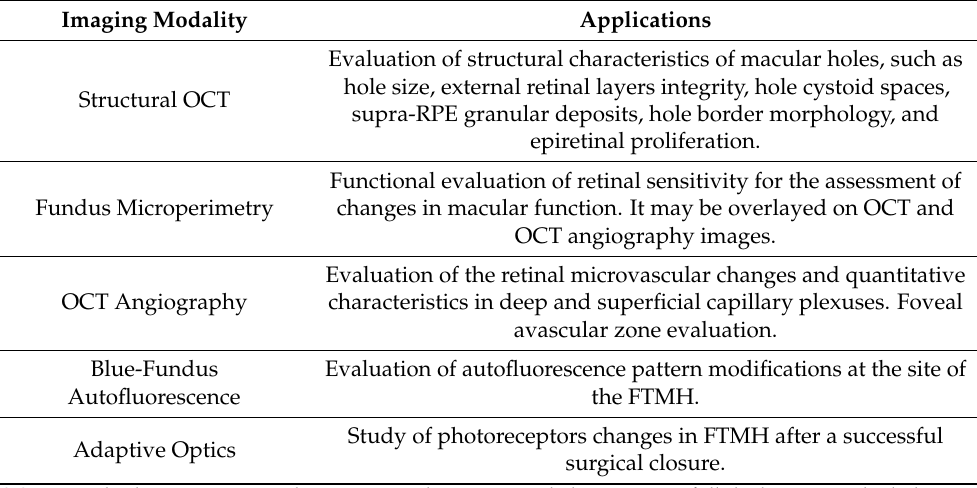
Table 1. The role of different retinal imaging modalities in the evaluation of full-thickness macular holes.